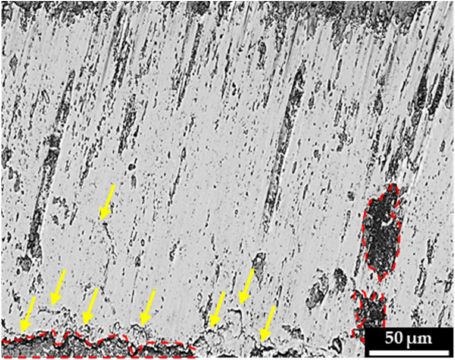
Figure 9. Optical micrograph of SS415 cladding depositions on hypereutectoid rail specimen. Red boundaries represent regions of spalling, and yellow arrows indicate surface cracking. The non-clad and Stellite 6 micrographs were published in a previous study by Roy et al. in Reference